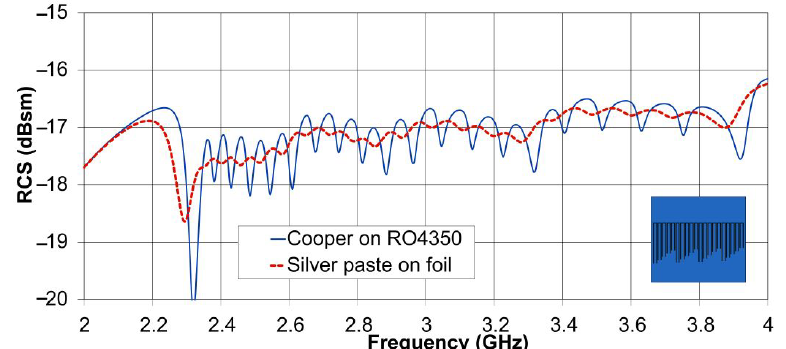
Figure 7. Simulated RCS of re-arranged U-slots in the metallic plate